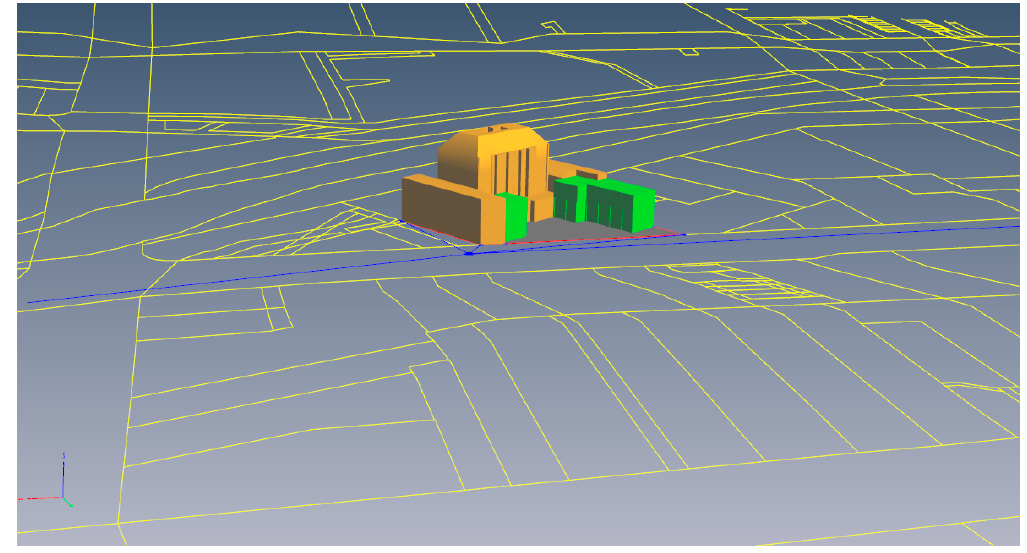
Figure 10. Perspective view of 3D parcels against the 2D parcel fabric.